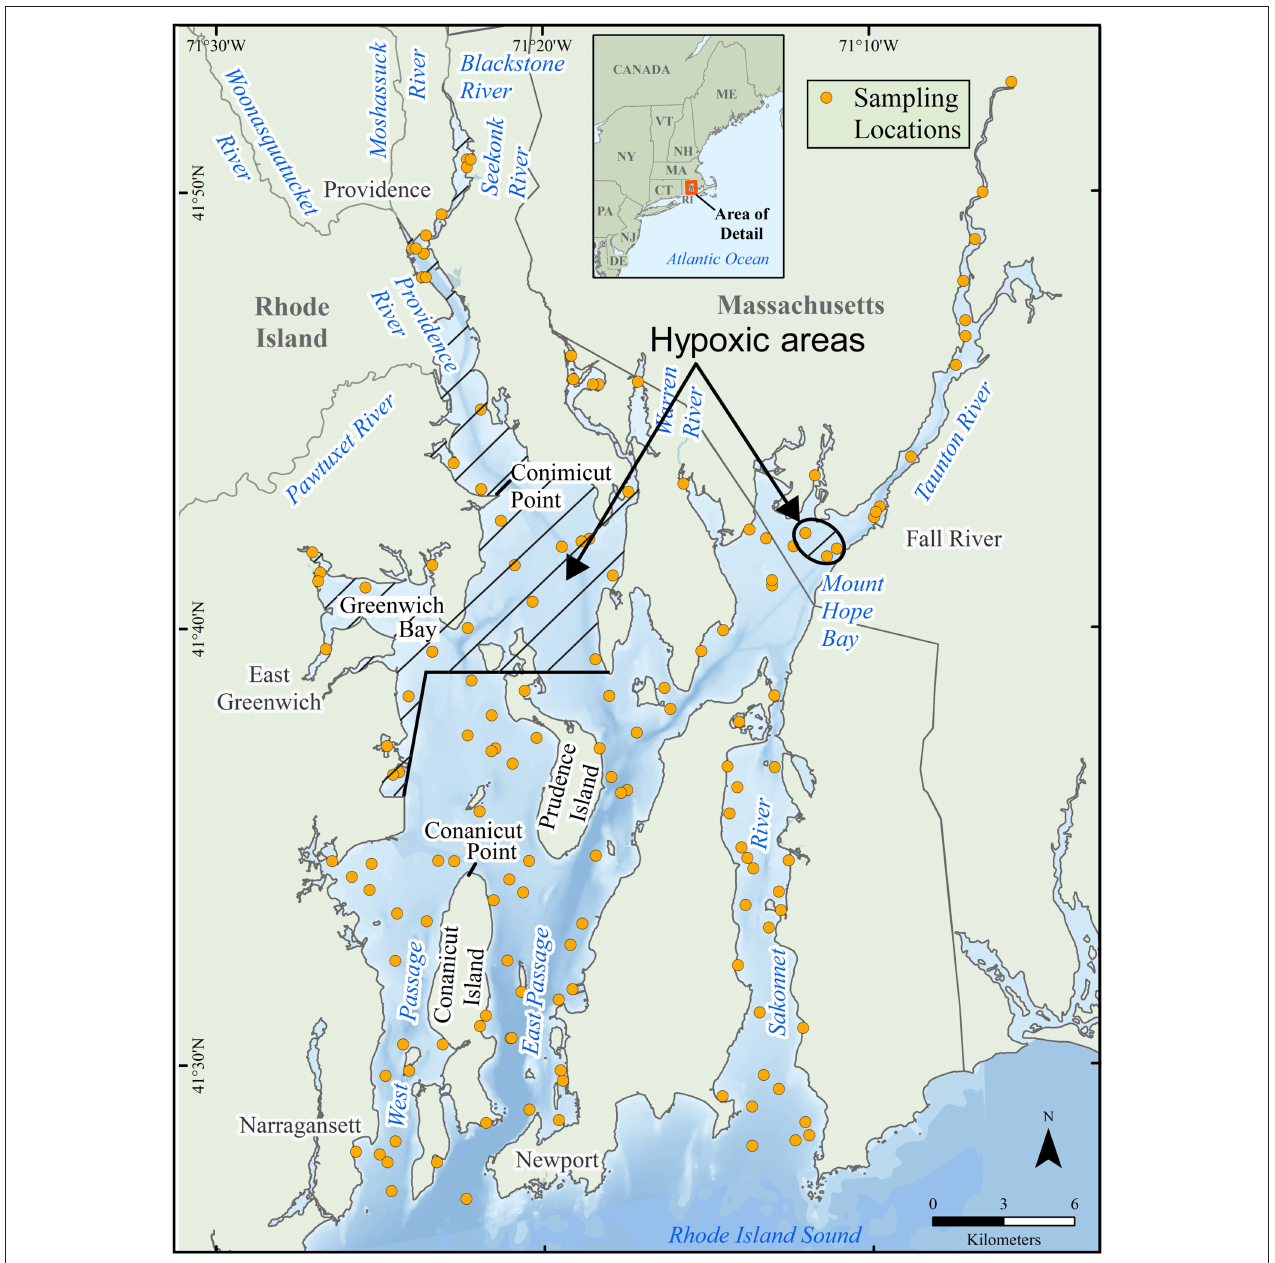
are spots inside the hypoxic areas that are not hypoxic every year and spots in the normoxic areas that are hypoxic some years. The 1990–2010 data were pooled, as the signal from sewage additions in the upper Bay dominates all other changes (Nixon et al., 2008) and the largest reductions in nitrogen input from the sewage treatment plants began after the last year of the NCA-NCCA dataset. Each area held a variety of habitat types included by the random selection of stations. The means can serve as